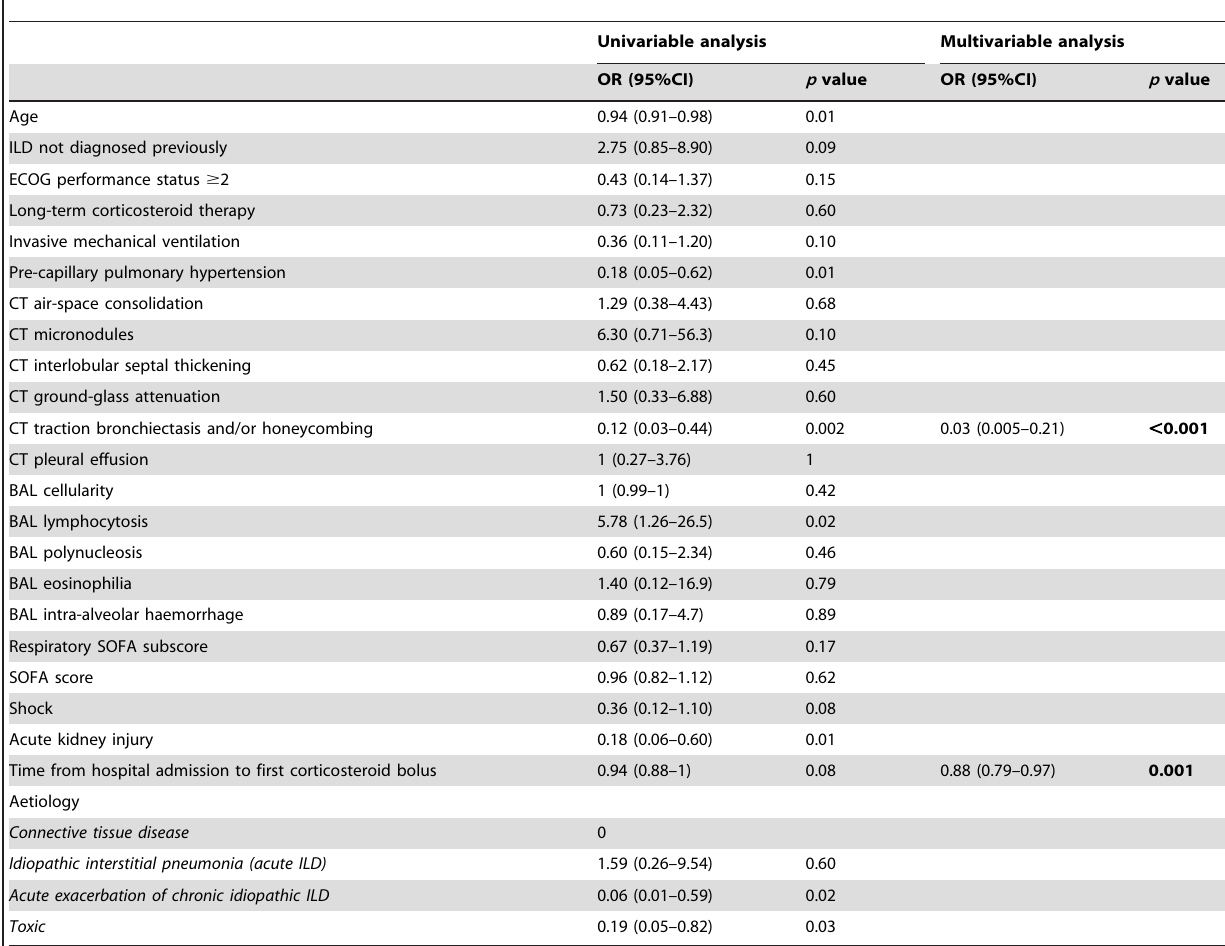
Table 5. Univariable and multivariable analyses of factors associated with responsiveness to high-dose